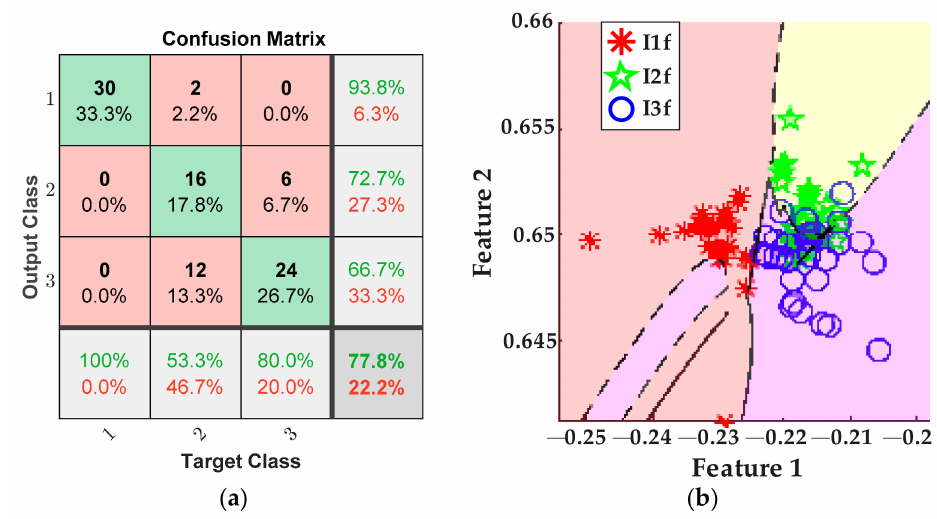
Figure 16. Results from feed rate variations for the AC current sensor; ( a ) confusion matrix and ( b ) ANN classification.